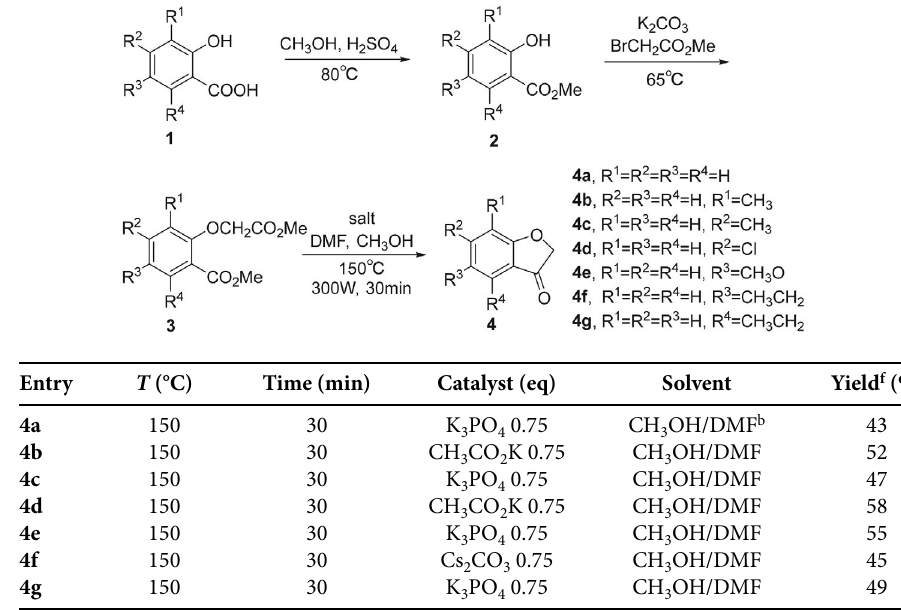
b N , N -Dimethylformamide. f Isolated yield. Scheme 2: Preparation of different benzoates and their cyclization under microwave